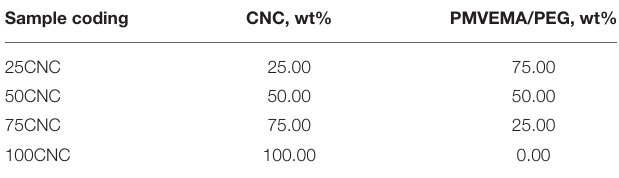
TABLE 1 | Composition of CNC